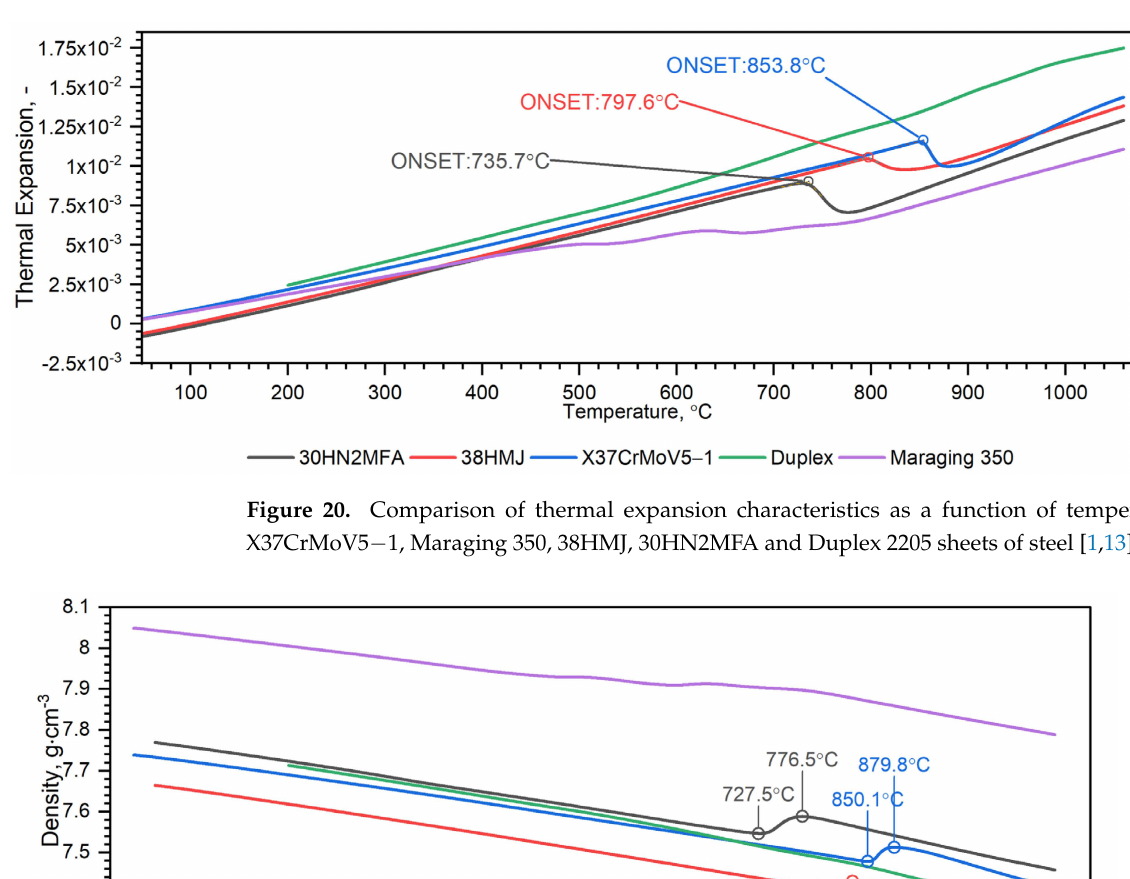
Figure 19. Comparison of thermal conductivity characteristics as a function of temperature for X37CrMoV5 − 1, Maraging 350, 38HMJ, 30HN2MFA and Duplex 2205 sheets of steel: ( a ) in the range − 50–500 ◦ C; ( b ) in the range RT–1000 ◦ C [1,13].